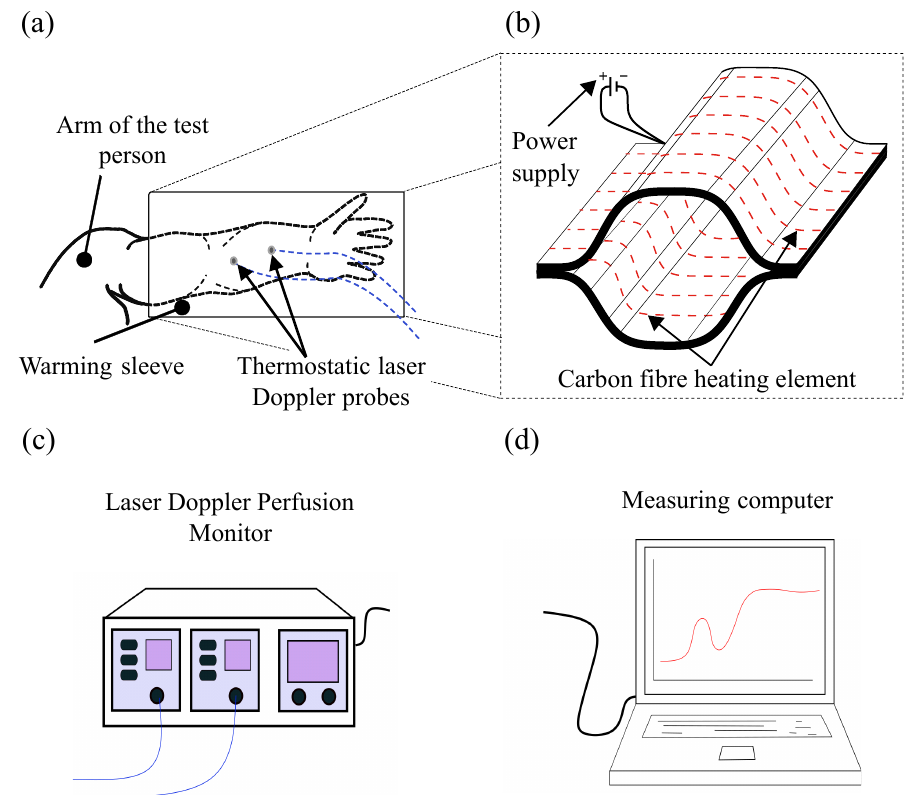
Figure 2. ( a ) Positioning of the warming sleeve and the measuring probes on the patient’s arm; ( b ) detailed view of the warming sleeve; ( c ) data processing; and ( d ) evaluation of the blood flow